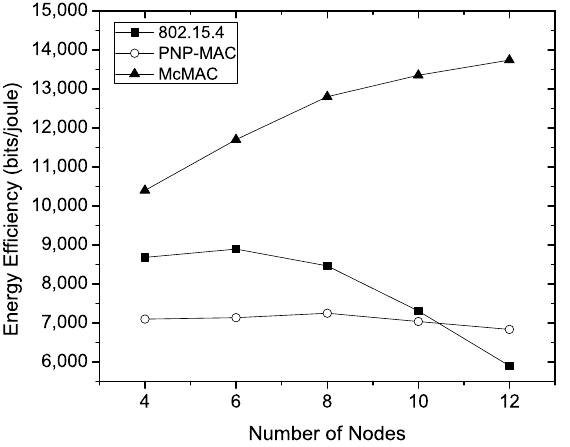
Figure 13. Energy efficiency at varying number of nodes.